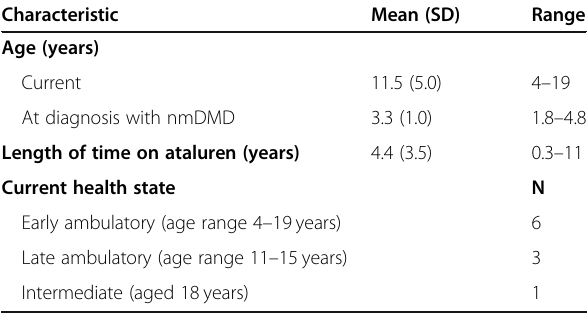
Table 2 Characteristics of individuals with nmDMD ( N = 10)